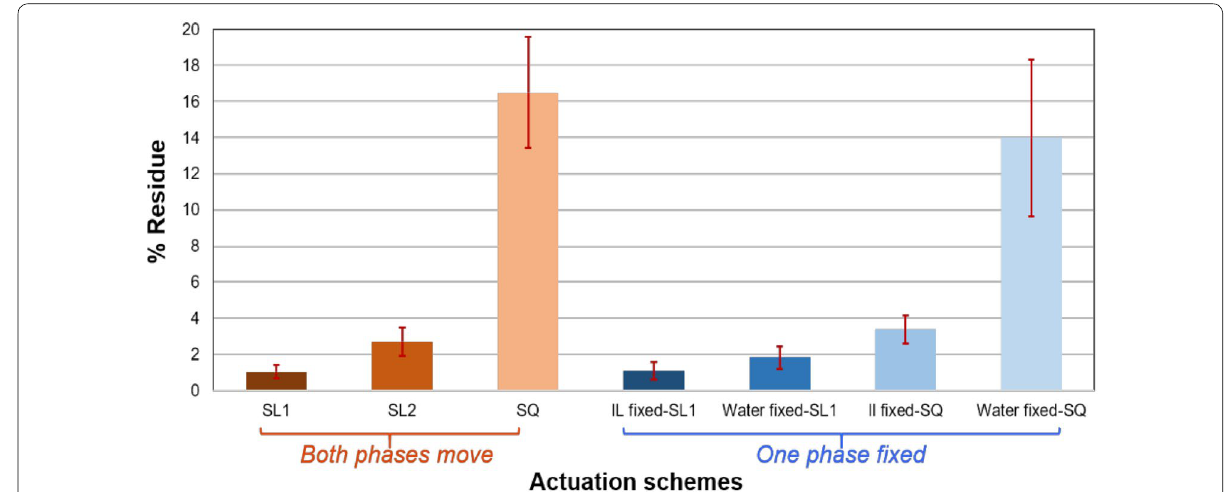
Fig. 10 Percent residue vs. schemes. Error bars represent standard